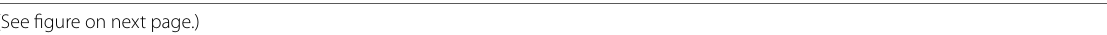
90%, no increased work of ≥ 10 mmHg; HFNO 2 , high-flow oxygen therapy; VMO 2 , venturi mask oxygen =